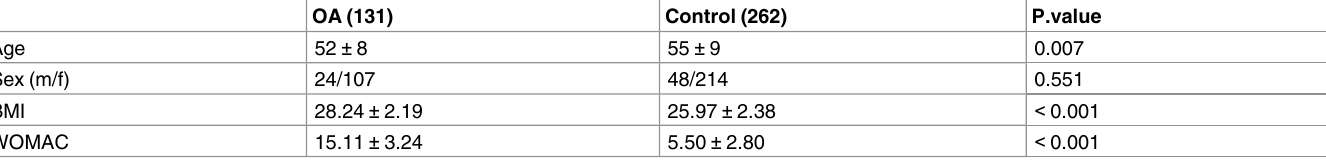
Table 1. Status of sex, age, BMI and WOMAC in OA patients and healthy controls.